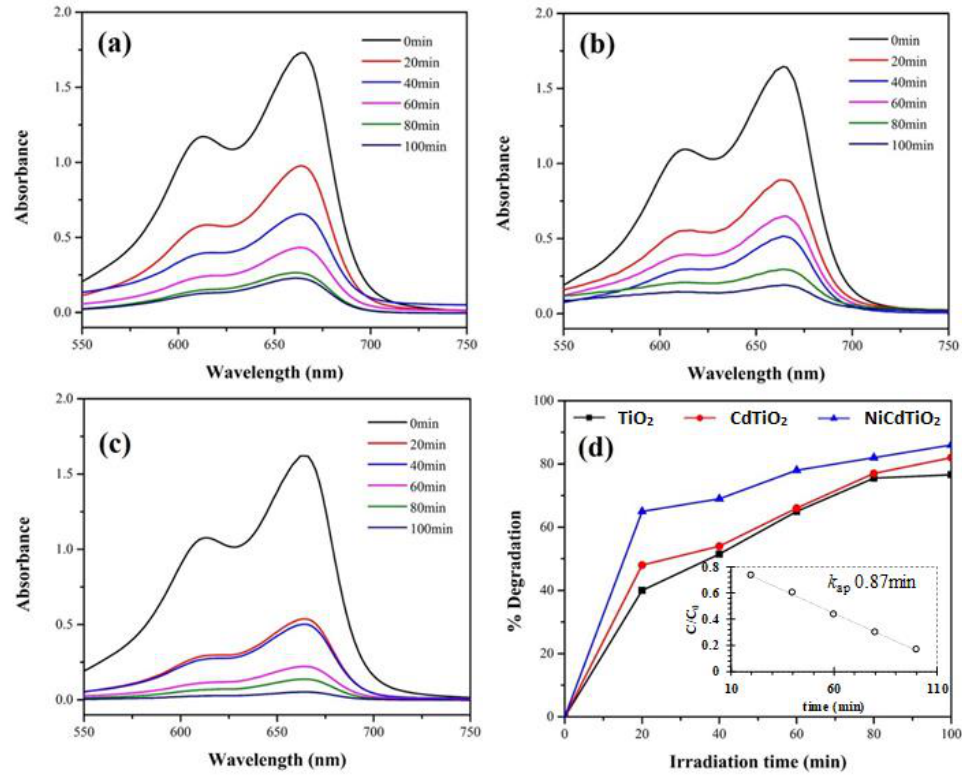
Figure 10. UV – Visible absorption spectra of MB photodegraded by ( a ) TiO 2 ( b ) CdTiO 2 ( c ) NiCdTiO 2 ( d ) Comparison of %degradation of MB dye inset kinetic model of degradation. ( d ) Comparison of %degradation of MB dye inset kinetic model of